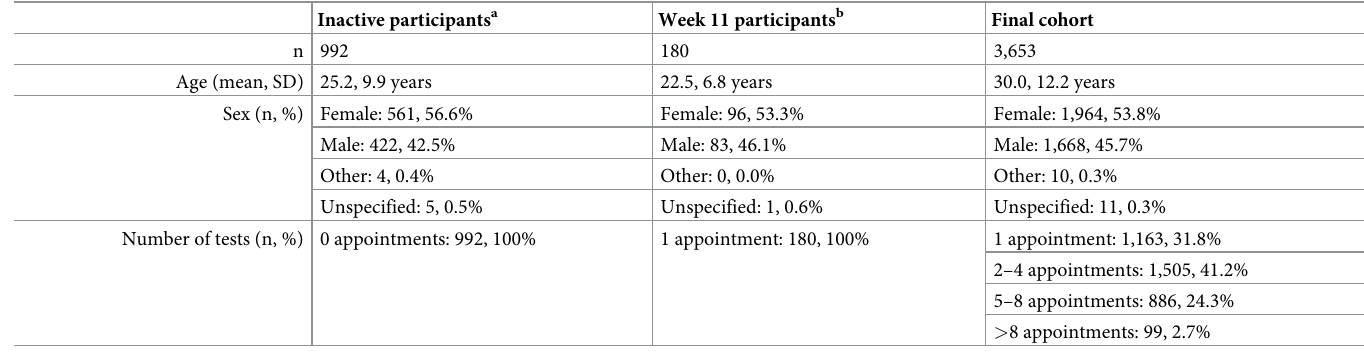
Table 1. Demographics of study